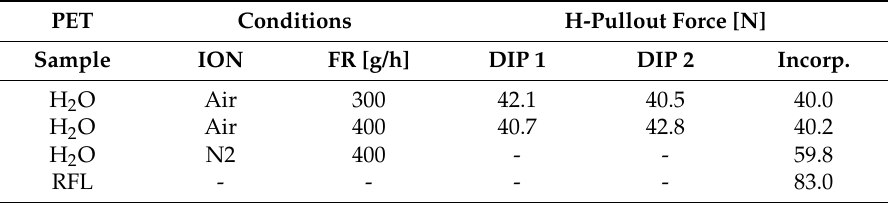
Table 4. H 2 O plasma-treated PET